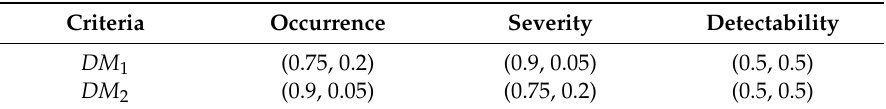
Table 14. Risk criteria judgements.